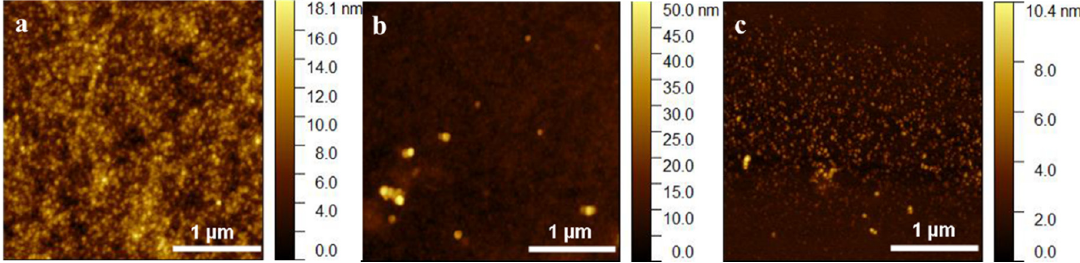
Figure 3. Atomic force microscopy (AFM) images of ( a ) pure chitosan, ( b ) gold–chitosan nanoparticles (AuNPs–chitosan), and ( c ) carbon nanoparticles (CNPs).